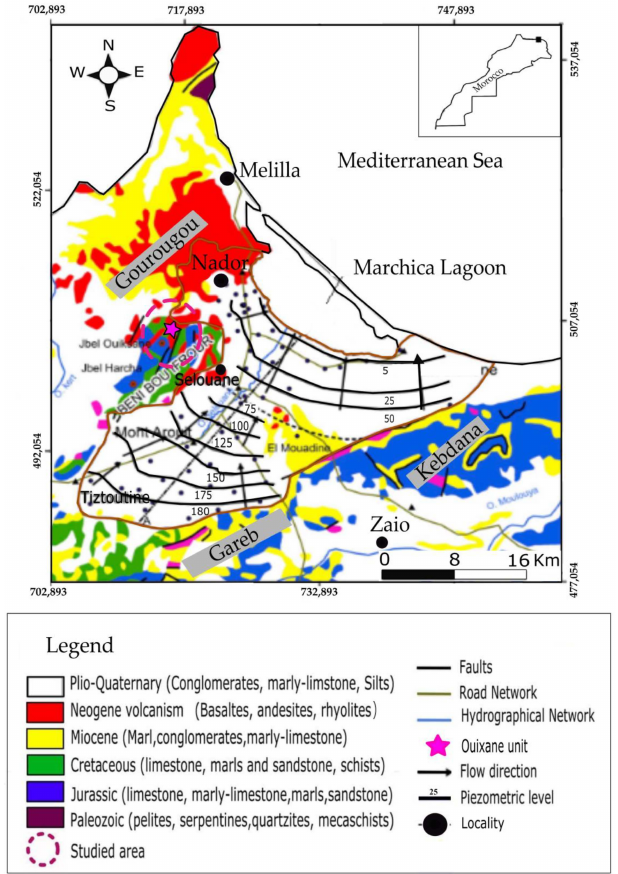
Figure 3. Piezometric and geological map of the study area based on the geological map of Morocco 1/1,000,000. Adapted from